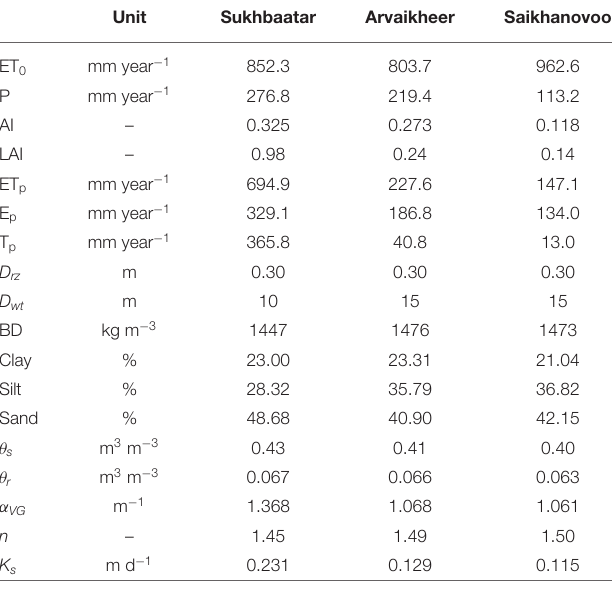
layers over the 41 weather stations.